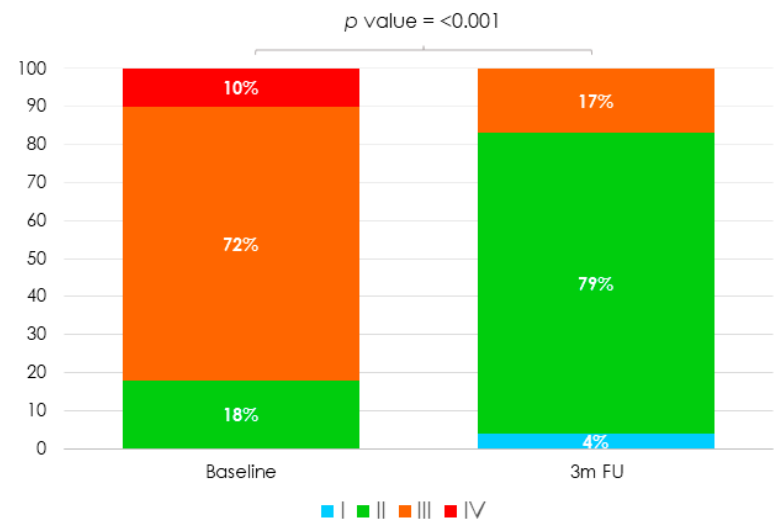
Figure 2. NYHA Functional Class at baseline and three-month